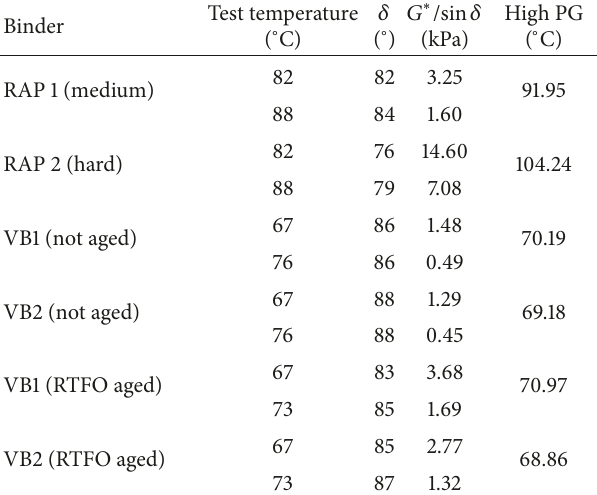
Table 1: DSR test results for RAP and virgin binders.